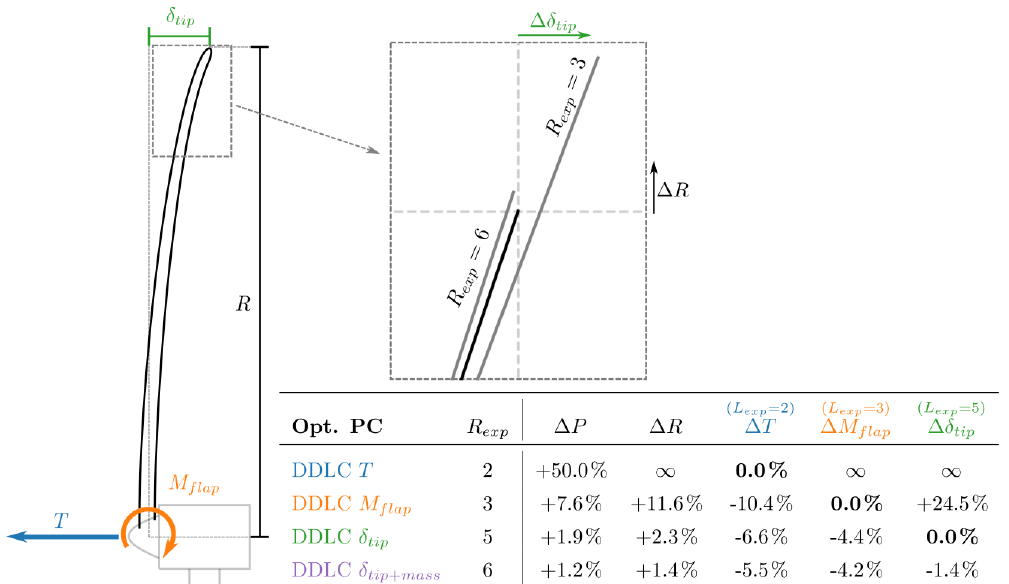
Figure 6. Sketch of a turbine with the load/structural response outlined. The zoomed-in figure shows the radius increase ( (cid:49)R ) and the change in tip deflection ( (cid:49)δ tip ) for two different DDLCs (bold black line is the baseline). The table shows the relative change in power, radius and load/structural response for different DDLCs. R exp = 2 is a thrust constraint design, R exp = 3 is a flap moment constraint design, R exp = 5 is a tip-deflection constraint design and R exp = 6 is the tip deflection+constant mass constraint